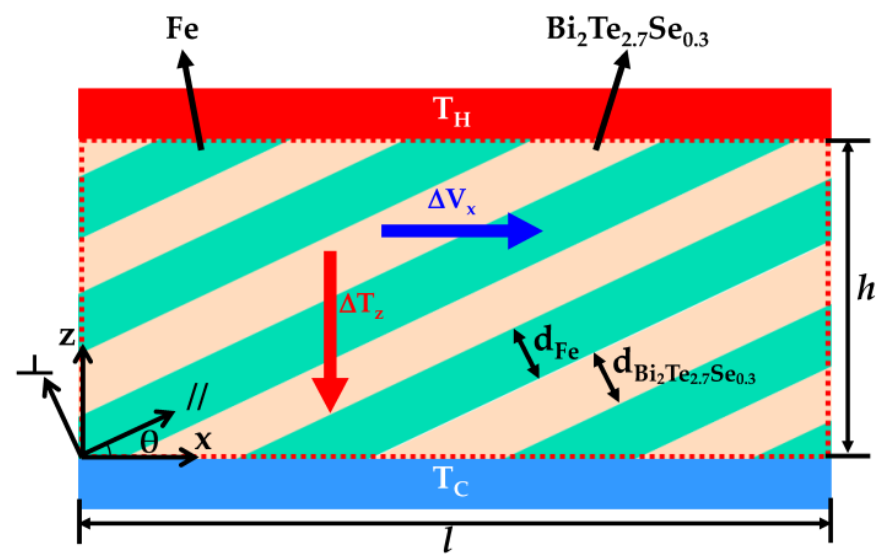
Figure 1. Simplified model of the Fe/BTS ATMTD from the sectional view.